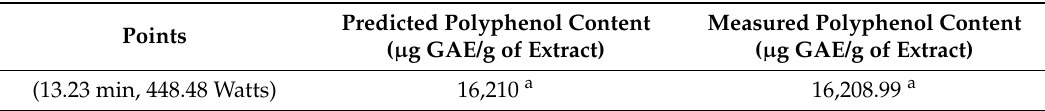
Table 5. Confirmation results of the model with the measured values and the predicted values of the studied responses.